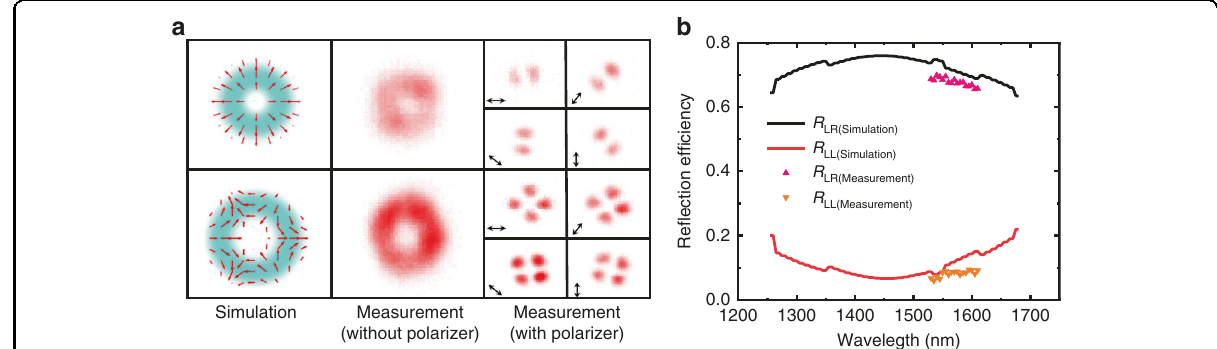
Fig. 3 Optical characterization of the metasurface-based CVB multiplexer/demultiplexer. a Left: simulated optical intensity distribution of the CVB at different diffraction order ( m = + 1 and m = − 2); middle and right: measured intensity pro fi les are shown both with and without a linear polarizer placed in front of the camera. b Simulated and measured re fl ection coef fi cients R LR and R LL for circularly polarized